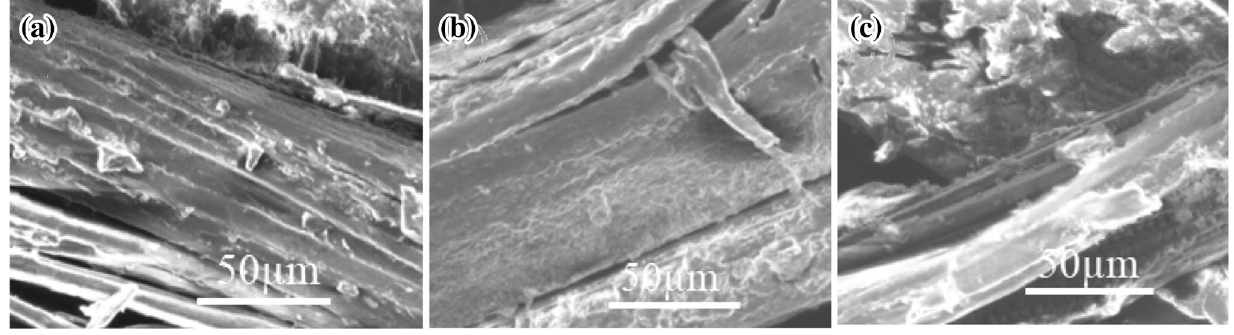
Fig. 7 SEM image of a 6% b 12% c 18% alkali treated Y.alpina bamboo fiber